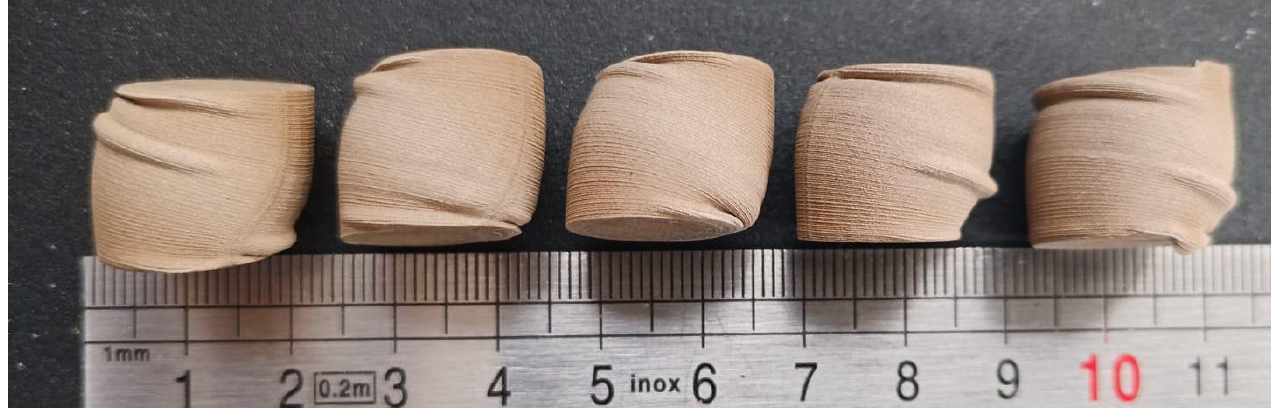
Figure 5. Vertically layered printed samples after compression load.